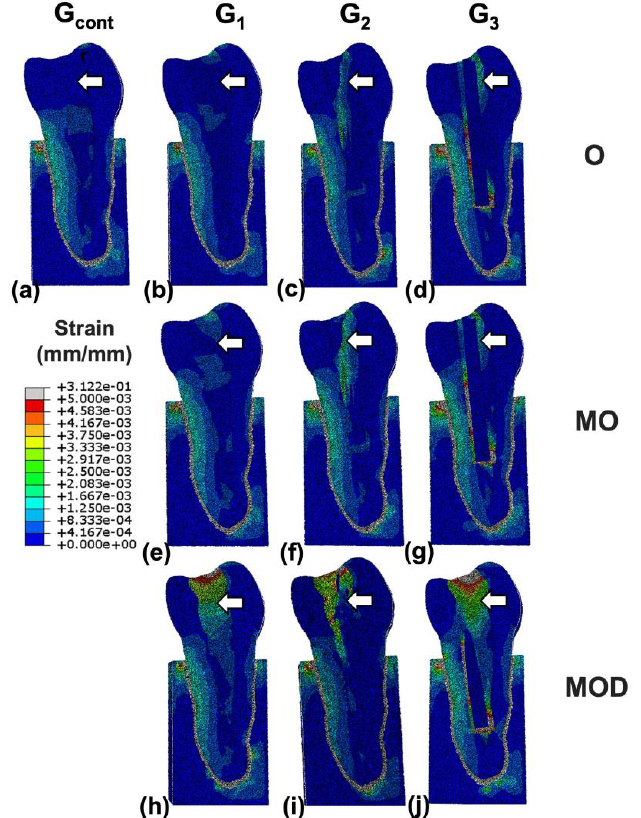
Figure 5. Strain distributions for finite element models representative of ( a ) intact, ( b ) occlusal (O) resin, ( c ) O multiple fiber-reinforced composite (mFRC), ( d ) O single fiber-reinforced composite (sFRC), ( e ) mesio-occlusal (MO) resin, ( f ) MO mFRC, ( g ) MO sFRC, ( h ) mesio-occluso-distal (MOD) resin reconstructions, ( i ) MOD mFRC and ( j ) MOD sFRC. Micro-fiber posts limit the transfer of stress in the resin in the radicular part in the contrary to sFRC, where strains are present all around the post (white arrows presenting different strains in the resin depending on the restorative choice). In addition, all samples including G contr displayed high stresses on the lateral parts of the root with low stresses in the center of the root (Figure 6).